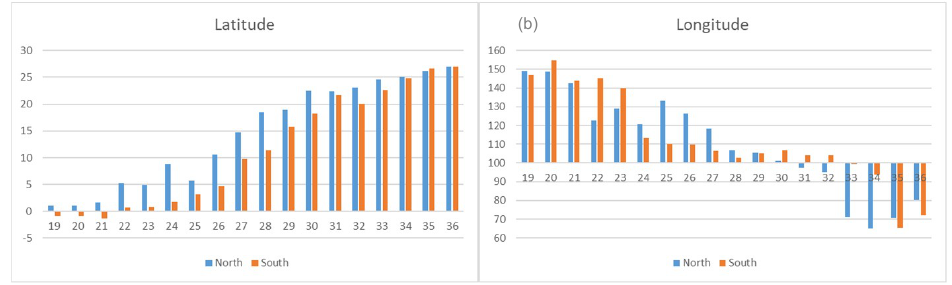
Figure 6. Composite evolutions of ( a ) latitude (°N) and ( b ) longitude (°E) of SAH gravity center from Pentad 19 to Pentad 36 for the North (blue) and South (orange) tracks.